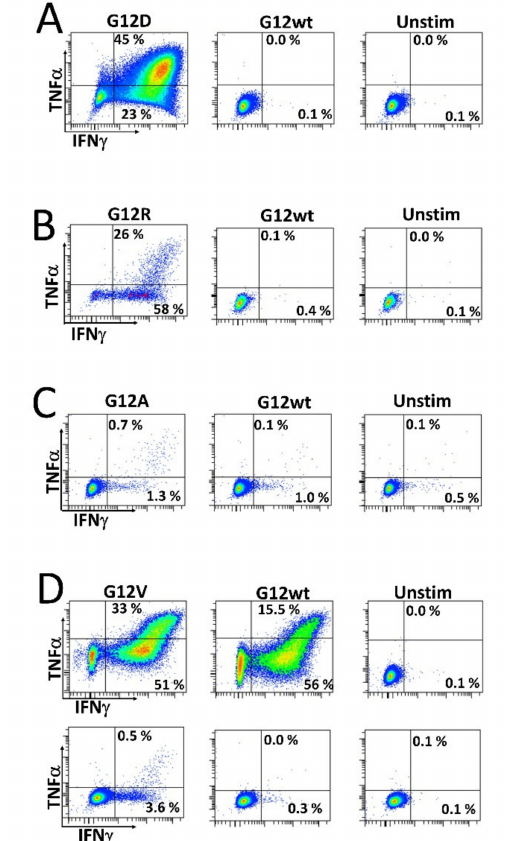
Figure 3. Stimulation of CD4 + T cell cultures established from healthy donor peripheral blood mononuclear cells. T cell clones were established as described in the Materials and Methods section and were subsequently stimulated with their corresponding mutant RAS epitope, wt RAS epitope, or left unstimulated. ( A ) Response against the G12D epitope and ( B ) G12R epitope response in a CD4 + T cell culture. ( C ) Response against the G12A epitope in a CD4 + T cell culture established by ex vivo stimulation as described the Materials and Methods section. ( D ) Response specific to the G12V peptide in a CD4 + T cell culture, with the standard 5 µ M concentration of peptide (top) and 0.5 µ M concentration